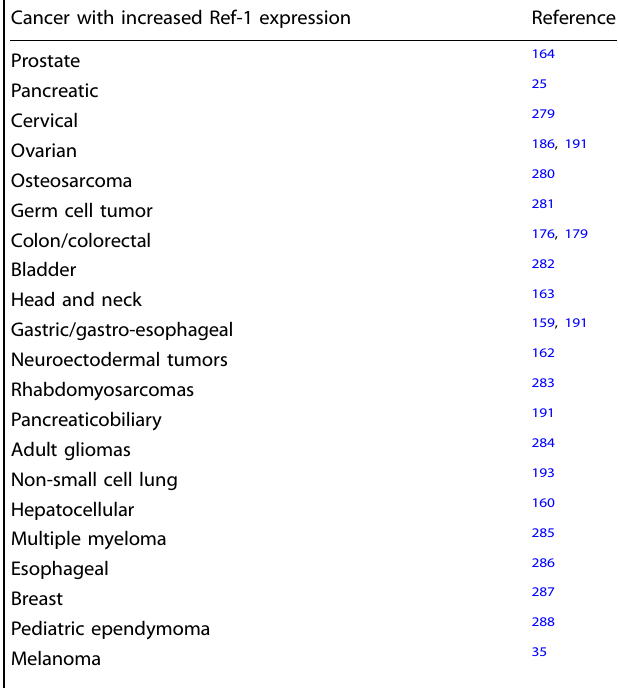
Table 2. Tumor tissues/cells with increased Ref-1 expression Cancer with increased Ref-1